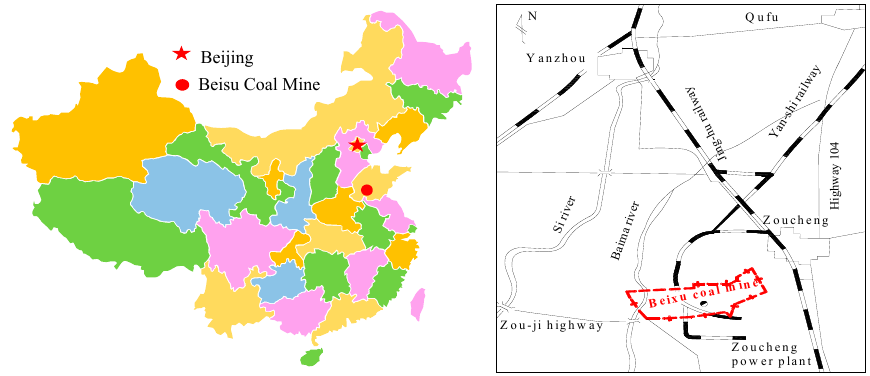
Figure 1. Position of the Beixu Coal Mine.